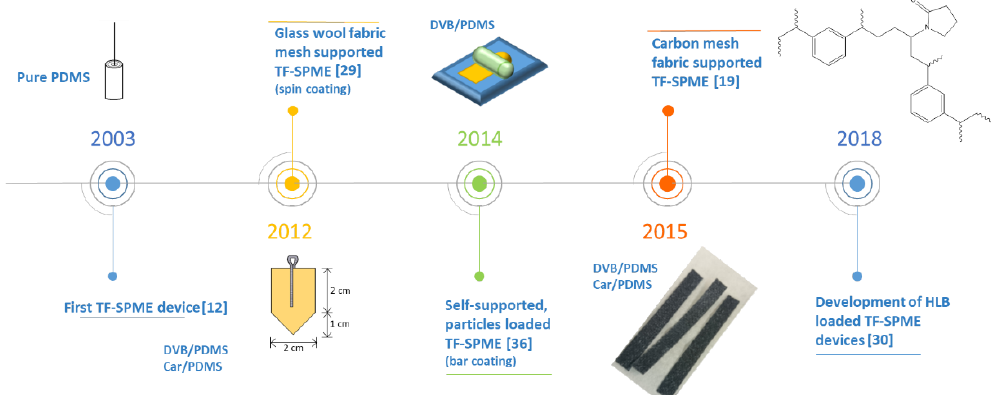
Figure3. AtimelineofpivotalmomentsintheevolutionofTF-SPMEdevices. PDMS,polydimethylsiloxane; Figure 3. A timeline of pivotal moments in the evolution of TF-SPME devices. PDMS, DVB, divinylbenzene; Car, Carboxen ® ; HLB, hydrophilic-lipophilic polydimethylsiloxane; DVB, divinylbenzene; Car, Carboxen ® ; HLB, hydrophilic-lipophilic balance.